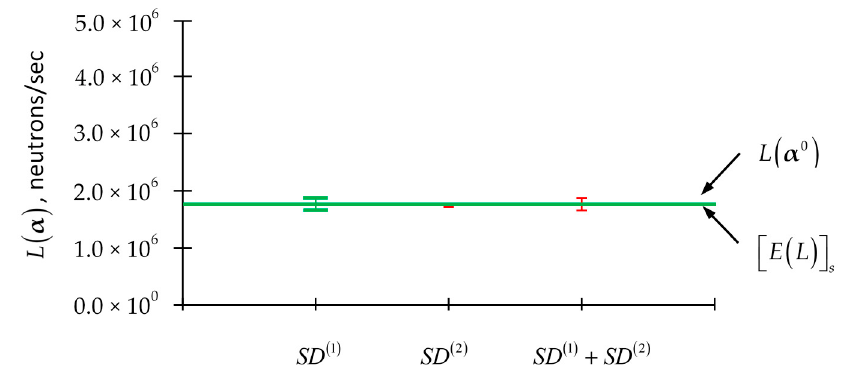
Figure 20. Comparison of (cid:16) (cid:17) ± SD ( 1 ) (in green), [ E ( L )] ± SD ( 1 ) , SD ( 2 ) , SD ( 1 ) + SD ( 2 ) (in red), α 0 L f due to 10% standard deviations of the parameters underlying the uncorrelated fission microscopic cross sections.